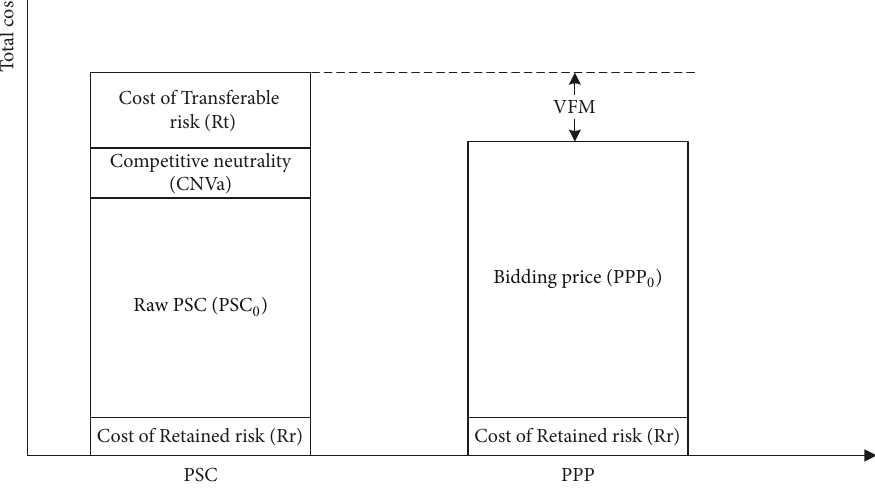
Figure 2: Assessing the VFM and